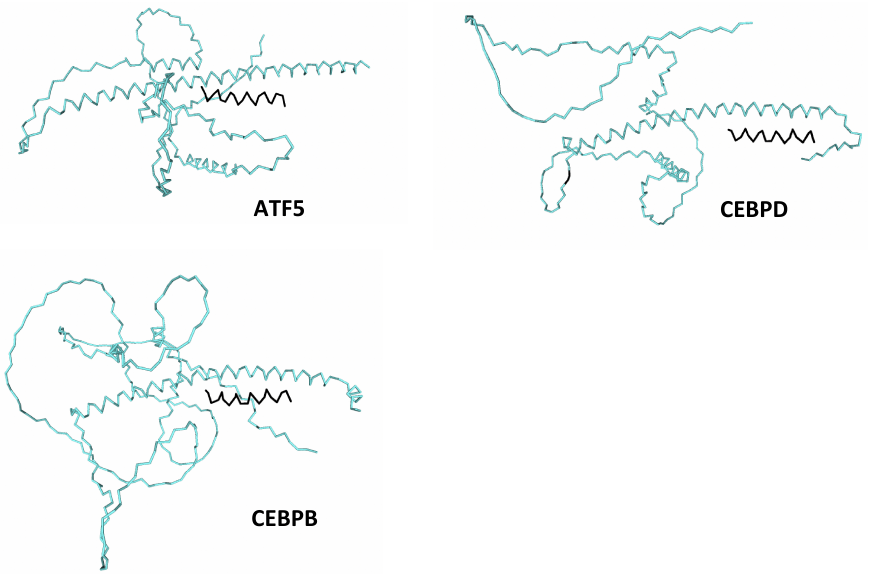
Figure 4. Computed sites for association of a portion of the CEBPD leucine zipper (21 amino acids, black) with ATF5, CEBPB and CEBPD. The molecular structures of ATF5, CEBPB and CEBPD were generated by the AlphaFold protein structure database [8,9]. The structure of the CEBPD leucine zipper peptide was computed by the PatchMAN protocol as were the docking sites for the peptide with ATF5, CEBPB and CEBPD [167]. The ensuing models were rendered using UGENE. In each case, the PatchMAN model 1 is shown. Table 1. Target specificities of reported cell-penetrating peptides with respect to ATF5, CEBPB and CEBPD. Data are presently unavailable for association of ST101 with CEBPD, but this appears likely given the similarity of its leucine zipper sequence to that of CP-DN-ATF5.